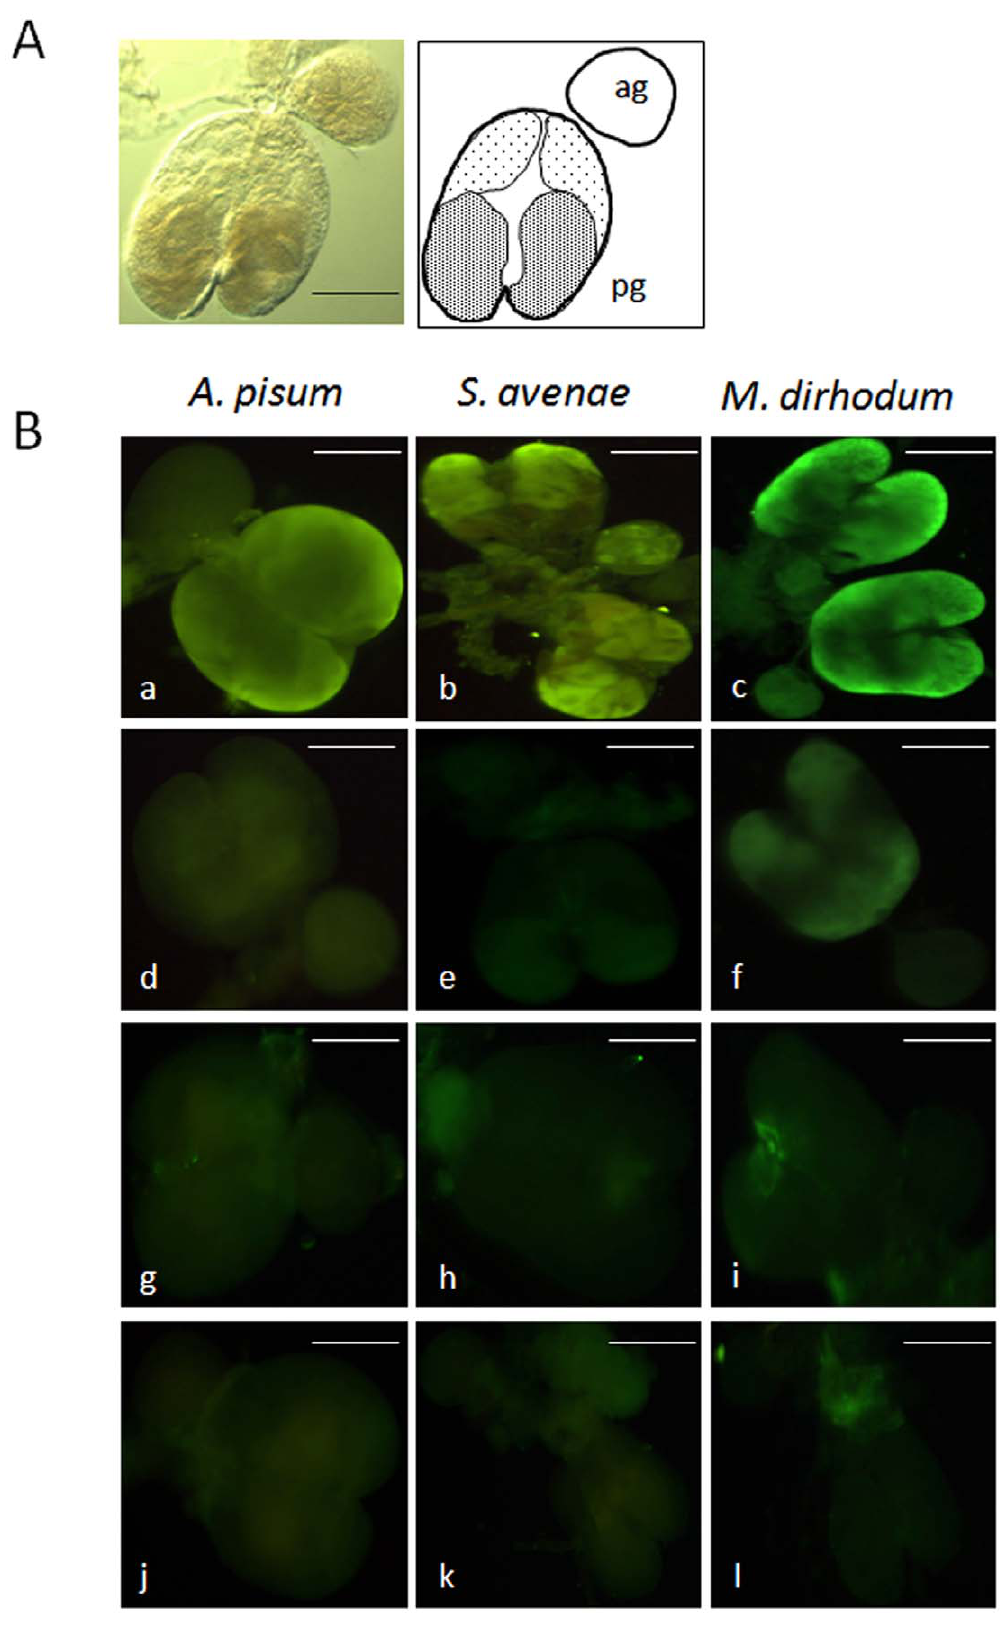
Figure 4. Aphid salivary gland morphology and immunohistochemistry (A) Freshly dissected salivary gland from A.pisum (left panel, x120, scale bar=100 m m) and line representation (right panel) indicating principal gland (pg) and accessory gland (ag) and